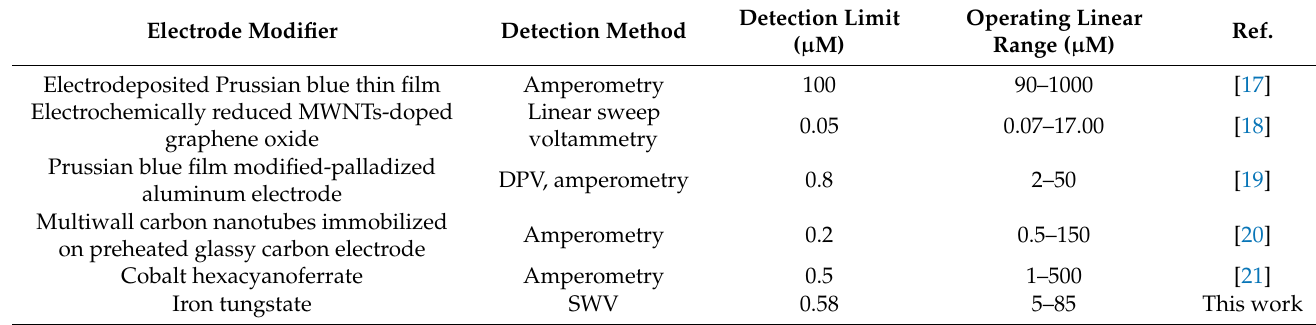
Table 1. Comparison of proposed method parameters with literature